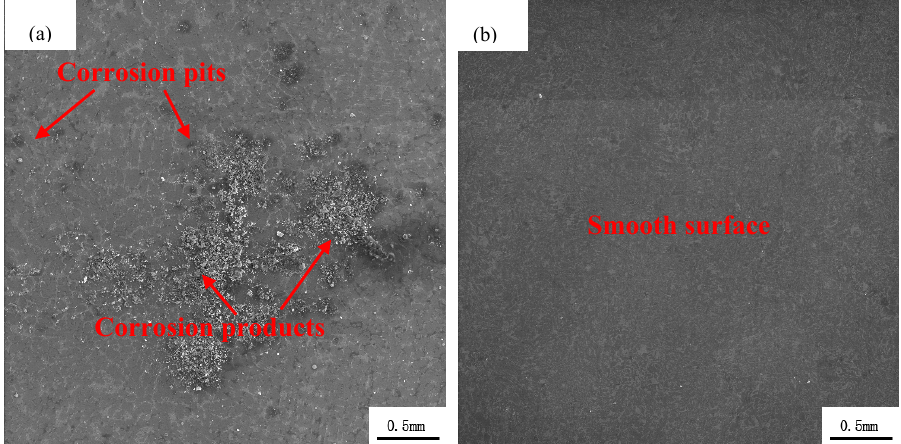
Figure 7. Corrosion morphologies of as-cast ( a ) and as-extruded ( b ) Mg 95.33 Zn 2 Y 2.67 alloy after the electrochemical impedance spectroscopy (EIS) test.